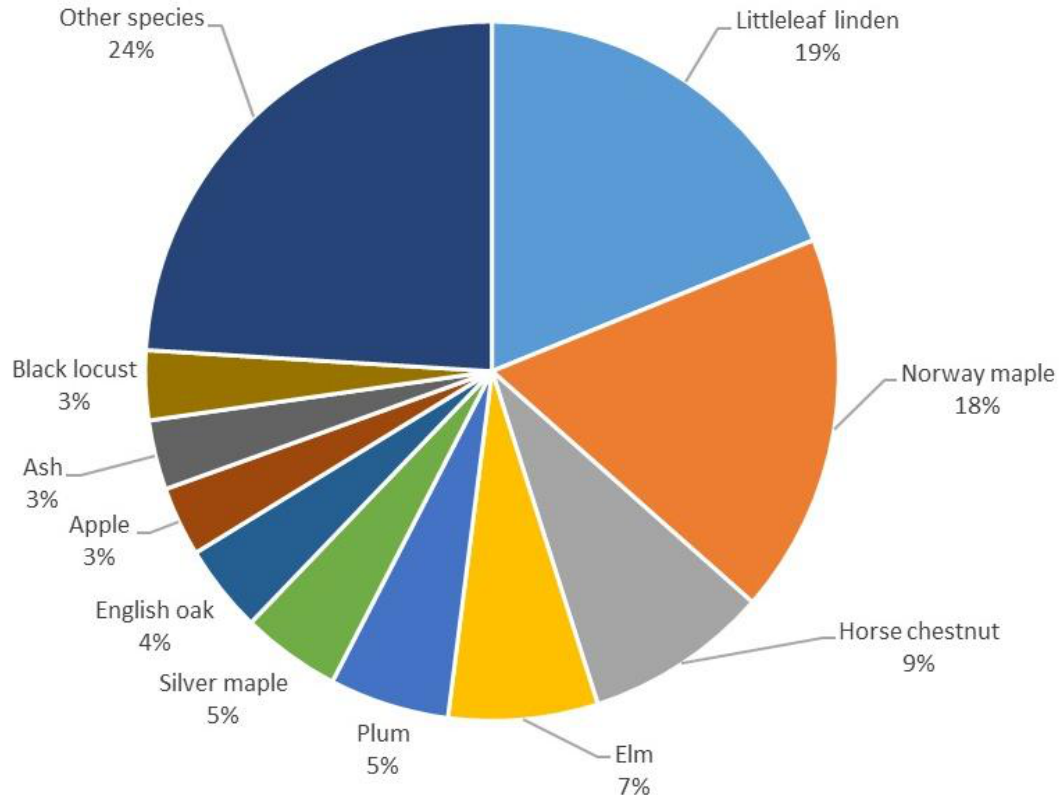
Fig. 3. Relative abundance of tree species in Krasiński Gardens (source: author’s own elaboration based on the results of the i-Tree Eco